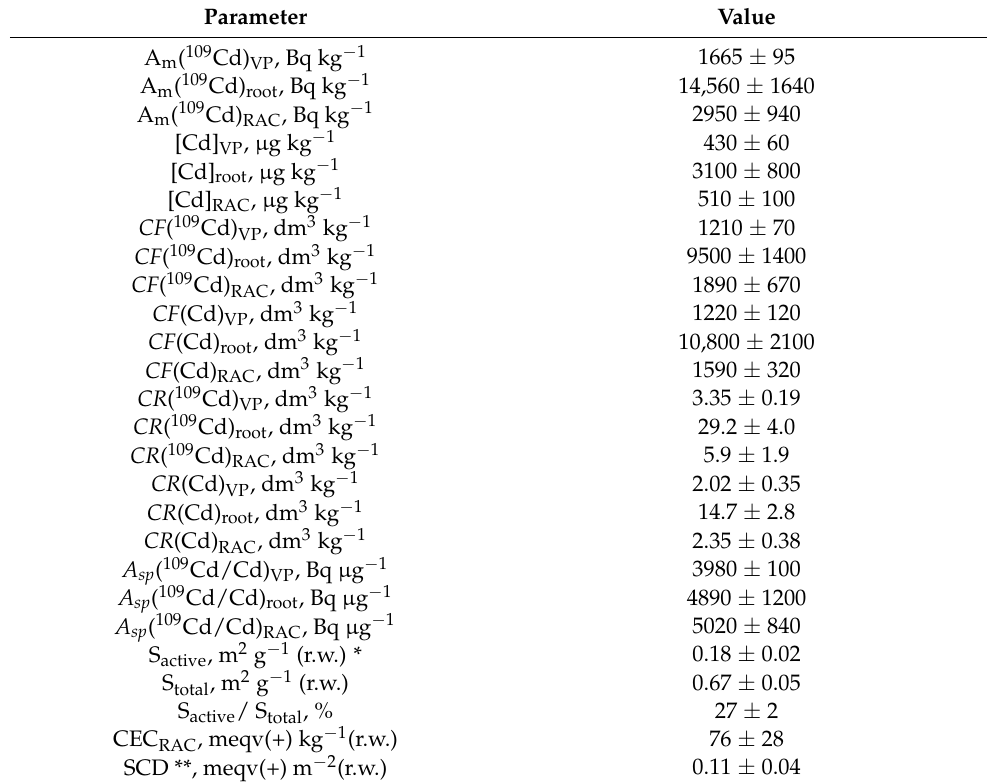
Table 1. Values of major 109 Cd (Cd) migration parameters in the soil–lysimeter solution–barley plant system per unit of dry weight (mean ± SD, n =